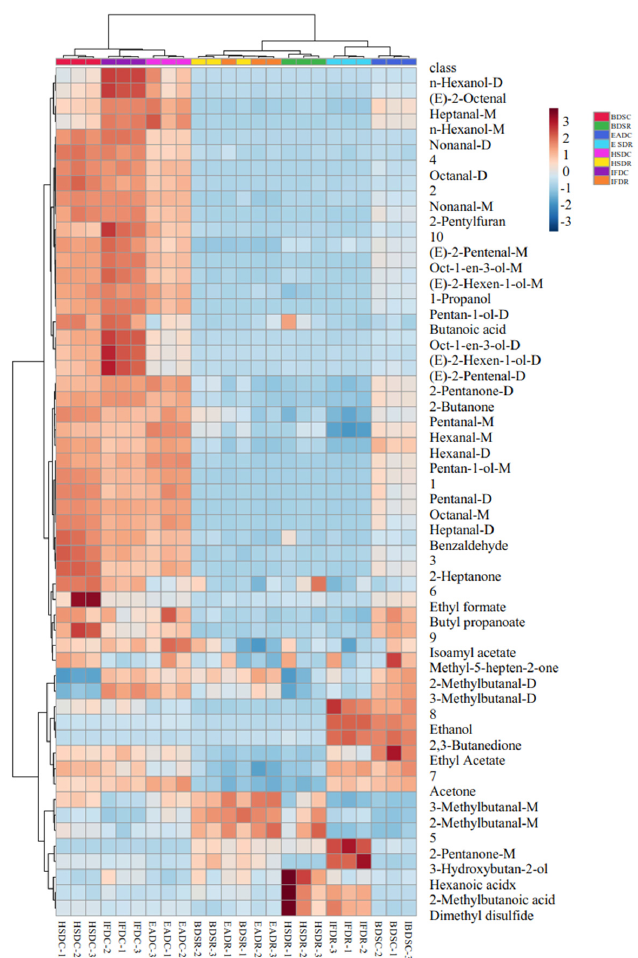
Figure 5. Heat map visualization of flavor-imparting compounds in raw (R) and cooked (C) sea bass subjected to different slaughter methods. IFD, ice faint to death; HSD, head shot control stun death; EAD, eugenol anesthesia to death slaughter; BDS, bloodletting to death